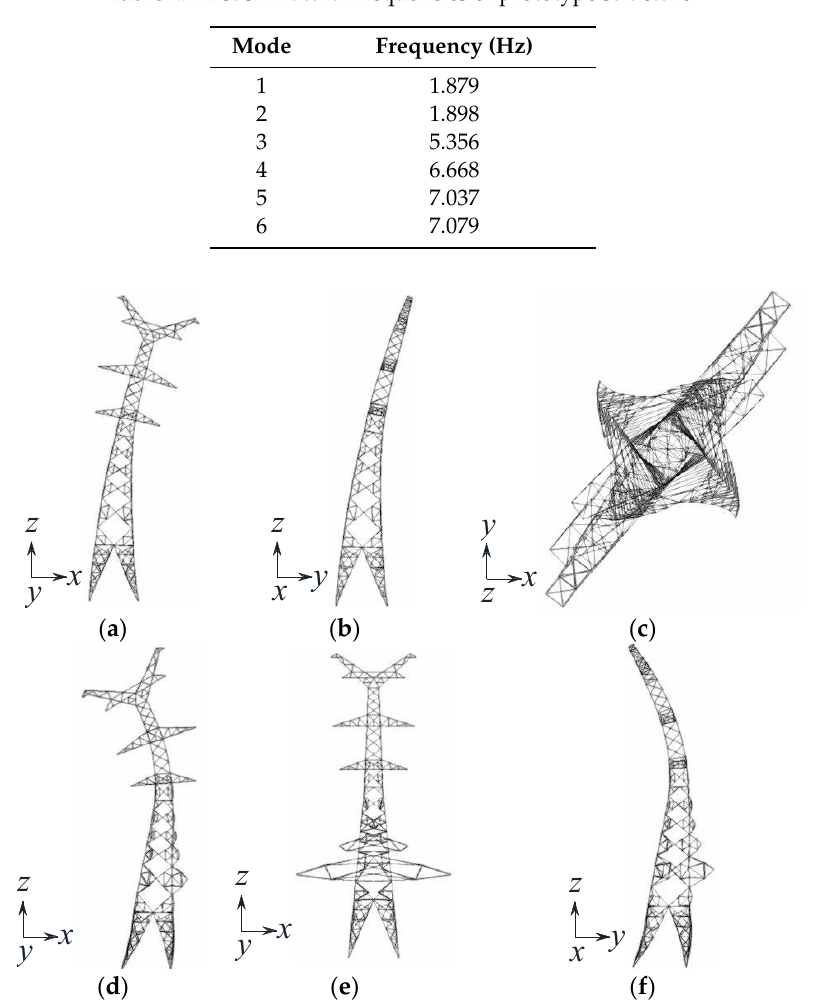
Table 2. First six natural frequencies of prototype structure.